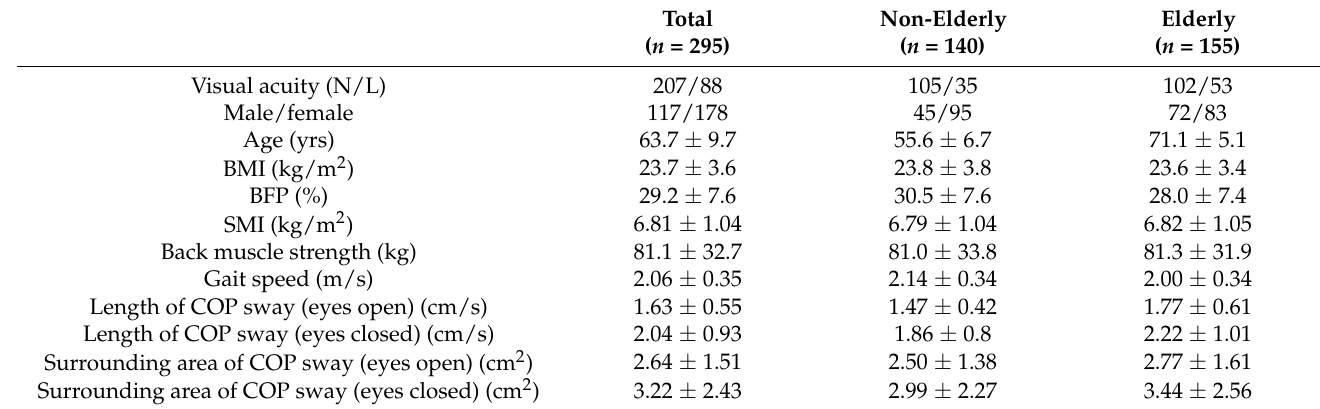
Table 1. Comparison of each parameter between non-elderly and elderly participants.